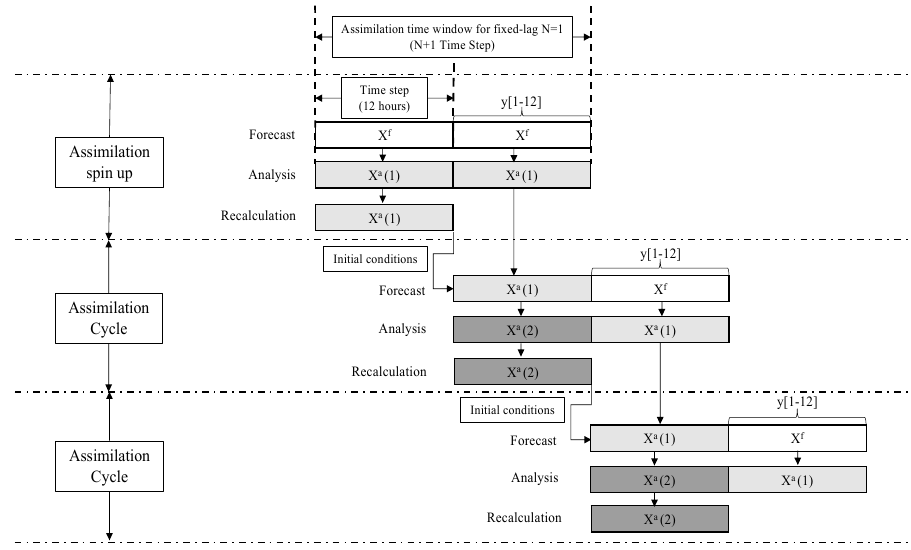
Figure 1. The flow chart of the Ensemble Kalman smoother system with a fixed-lag value N = 1 for dust emission inversions. The white and dark shaded boxes denote the first guess and final optimized dust emission ensembles, respectively. The light shaded boxes denote the intermediate optimized dust emission ensembles that need to be optimized in the next cycle. The number in parentheses indicates how many times the dust emissions have been optimized.